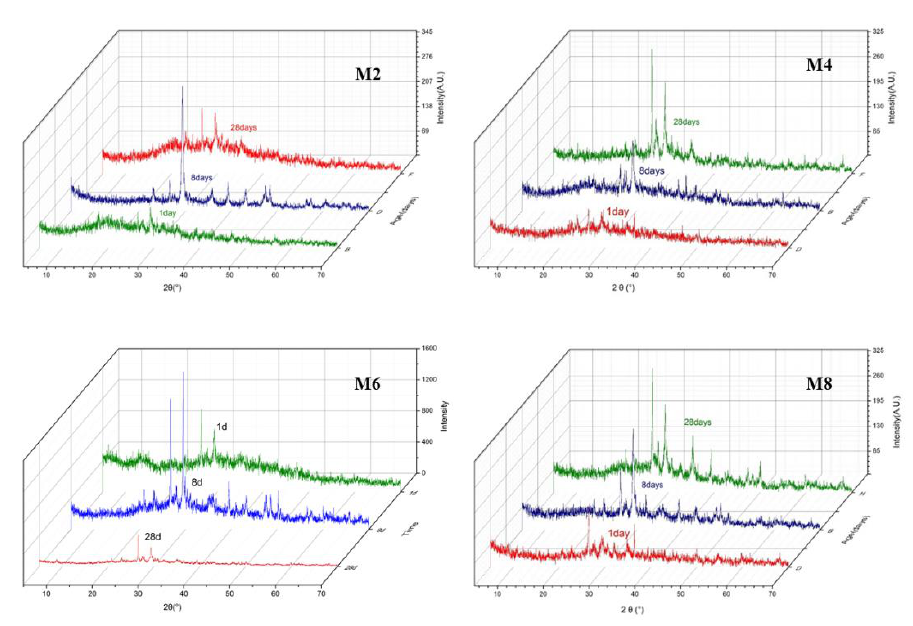
Figure 5. XRD patterns of SAR paste at 1, 8, and 28 days.